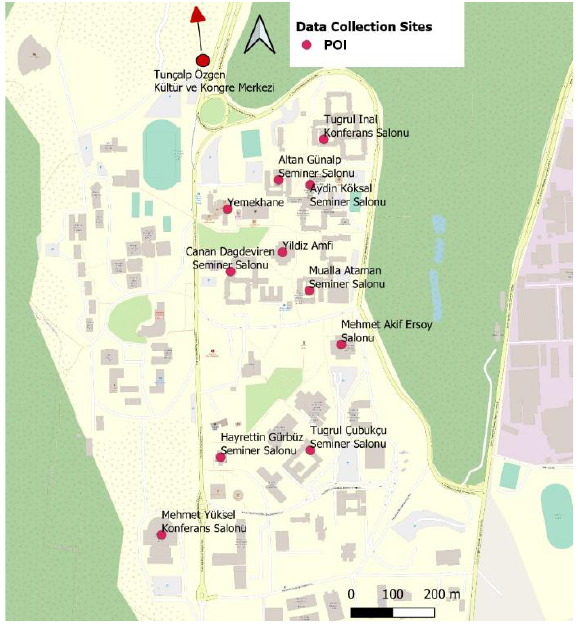
Figure 4. Data collection sites and POIs of the direction estimation task